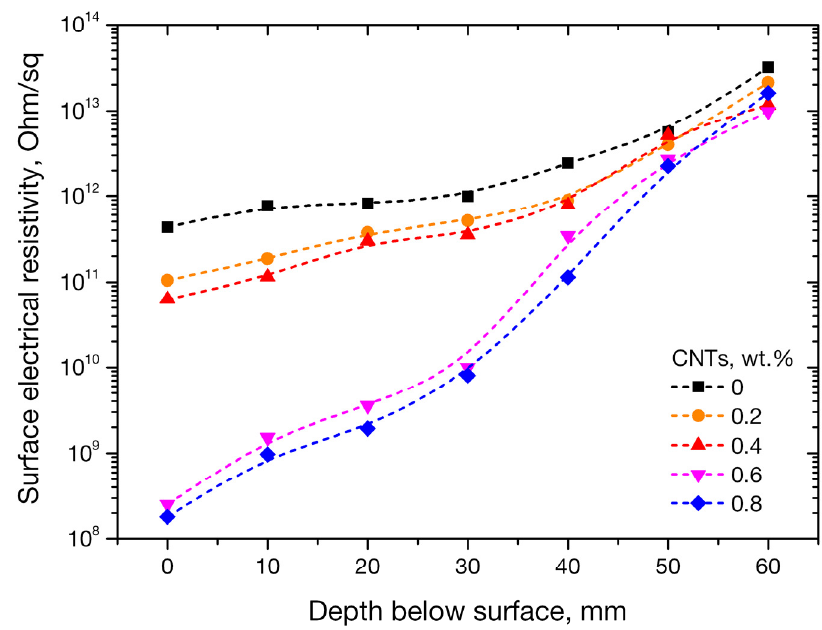
Figure 11. Surface electrical resistivity with respect to the depth below the exposed surface for all the nano-modified cement mortar.